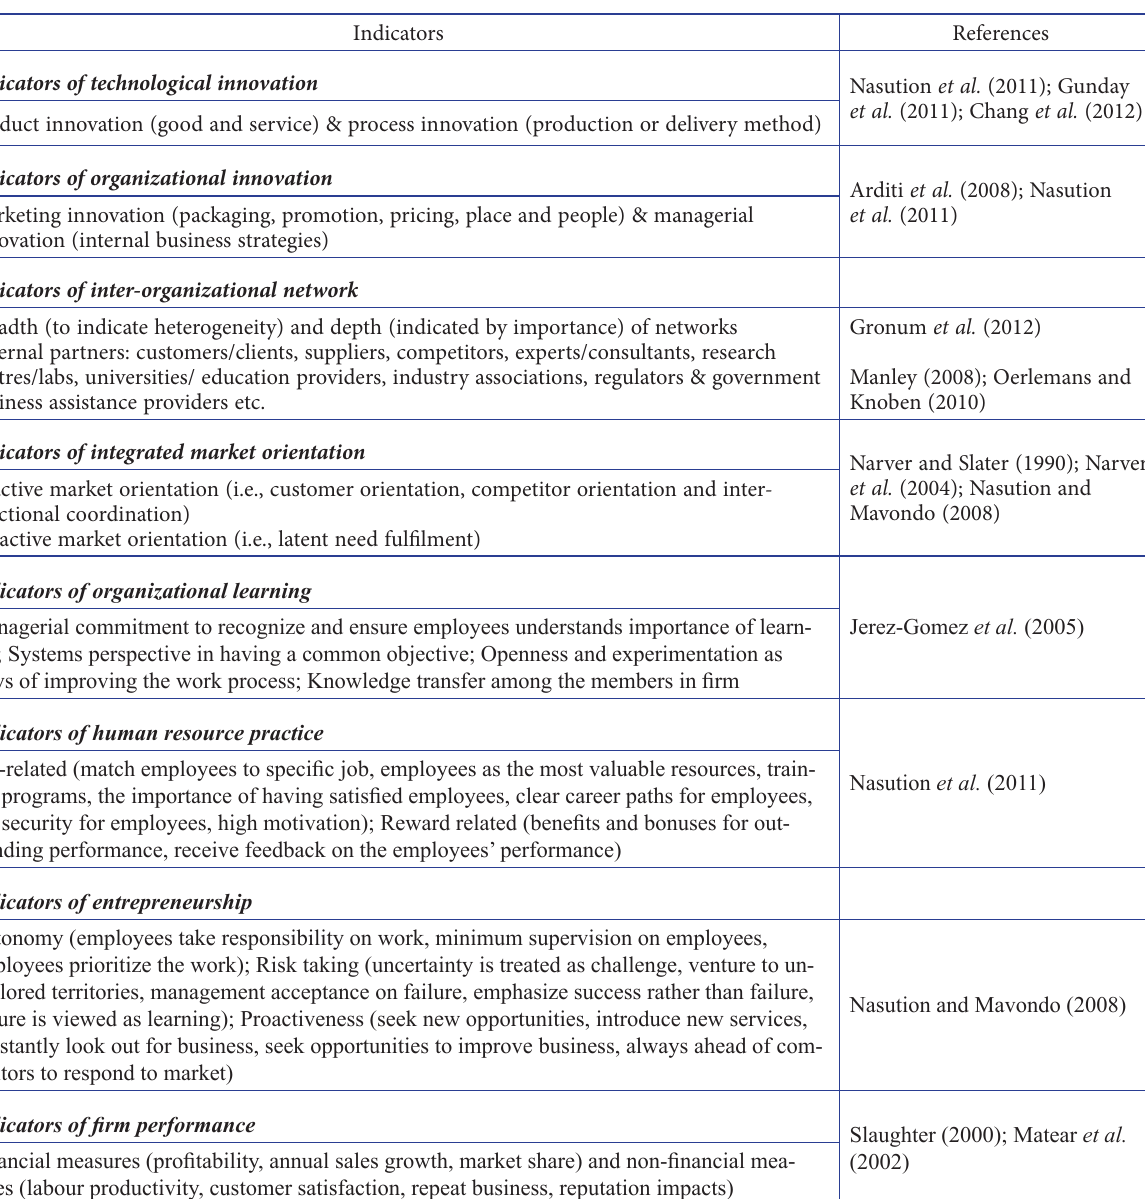
Table 2. Indicators of